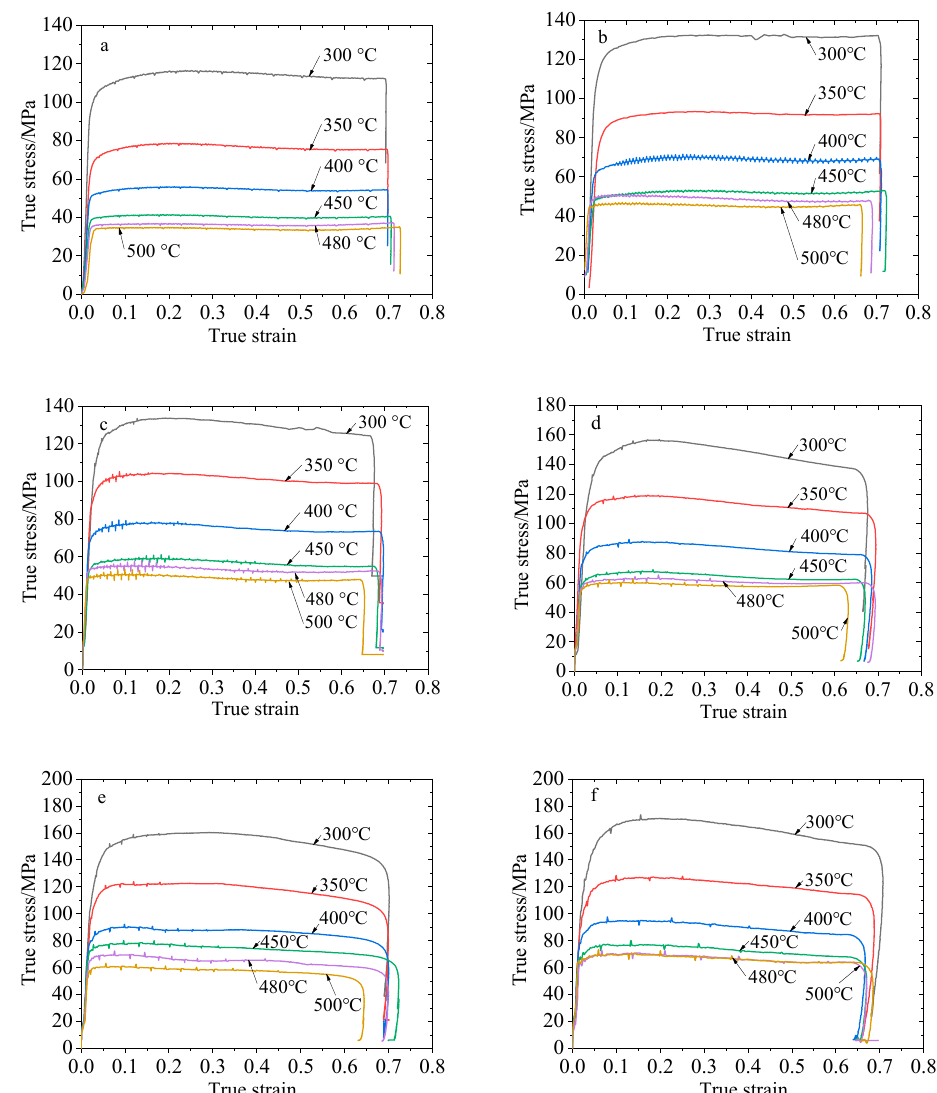
Figure 3. True stress–strain curves of 2219 aluminum alloy under different deformation conditions: ( a ) 𝜀(cid:4662) = 0.1 s − 1 ; ( b ) 𝜀(cid:4662) = 1 s − 1 ; ( c ) 𝜀(cid:4662) = 3 s − 1 ; ( d ) 𝜀(cid:4662) = 5 s − 1 ; ( e ) 𝜀(cid:4662) = 8 s − 1 ; ( f ) 𝜀(cid:4662) = 10 s − 1 .